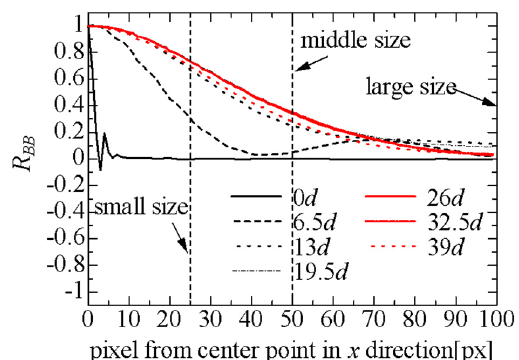
Figure 7. Autocorrelation coefficient of the brightness fluctuation value of each pixel, calculated from the image data of distribution for S integral .